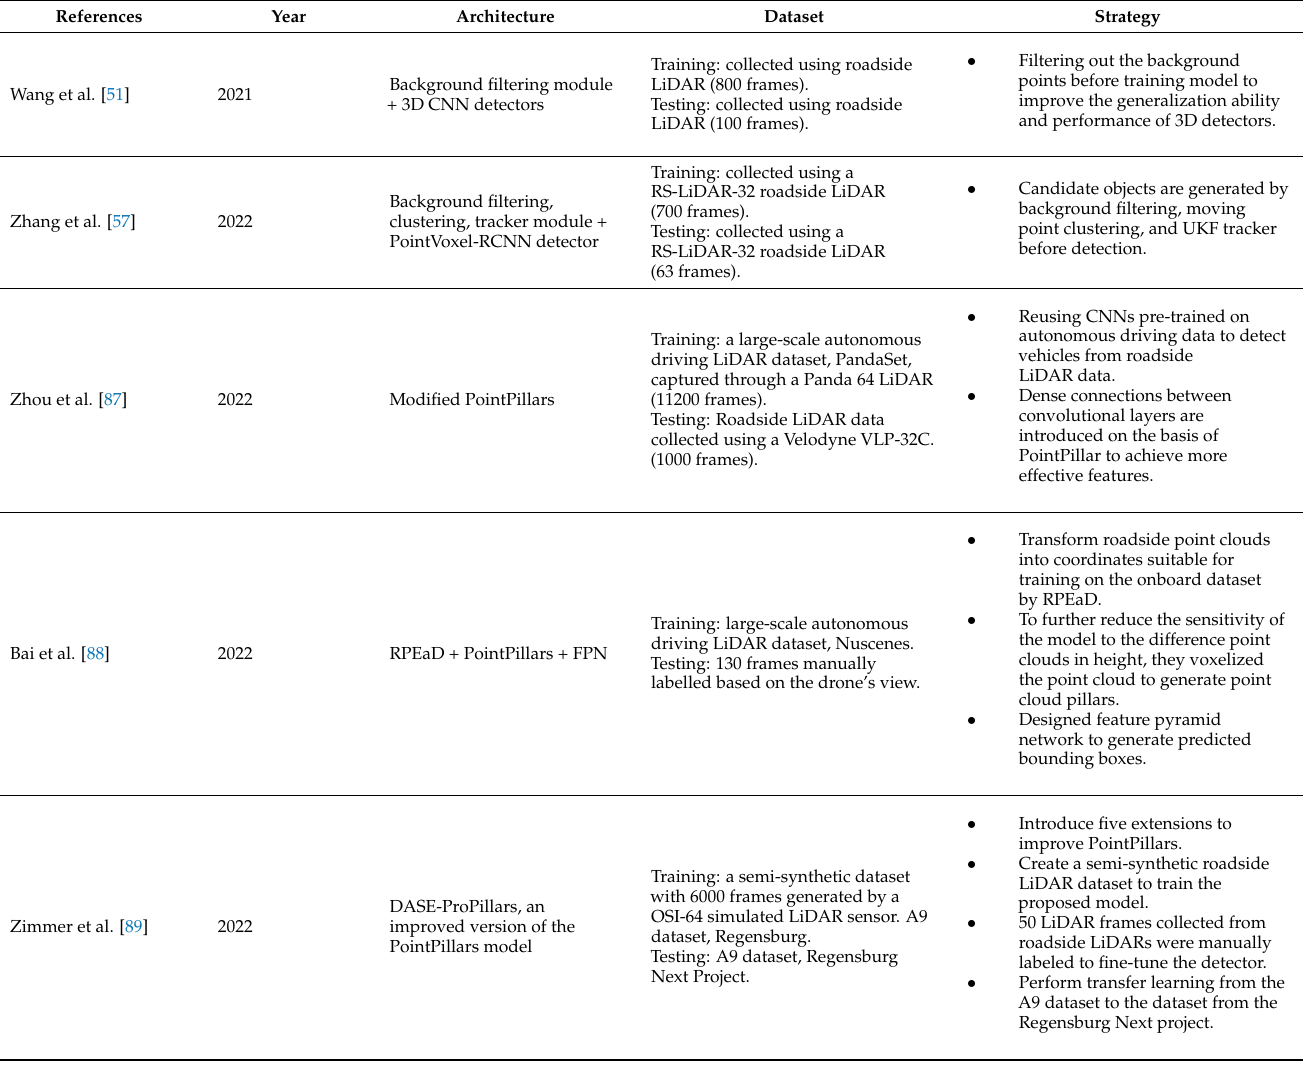
Table 4. Comparison of object detection methods for roadside LiDAR based on deep